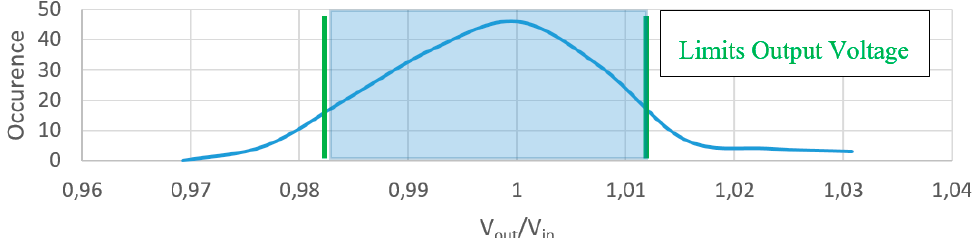
Figure 18. Illustration of window tolerance out of which CSC are declared out of the spec and removed from the supply chain.